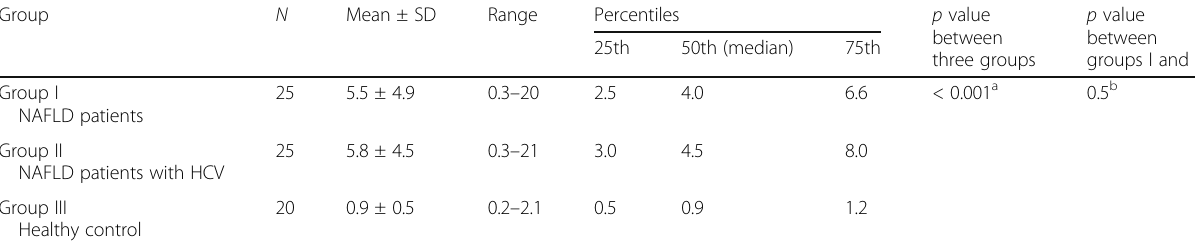
Table 3 Comparison between the studied groups as regard plasma PTX3 (ng/mL) Group